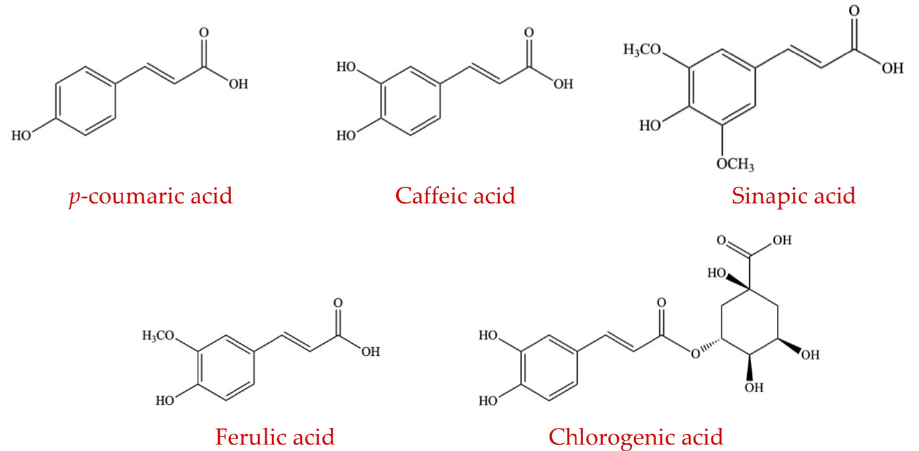
Figure 13. Chemical structures of hydroxycinnamic acids ( p -coumaric acid, caffeic acid, sinapic acid, ferulic acid, and chlorogenic acid) (self ‐ generated) .